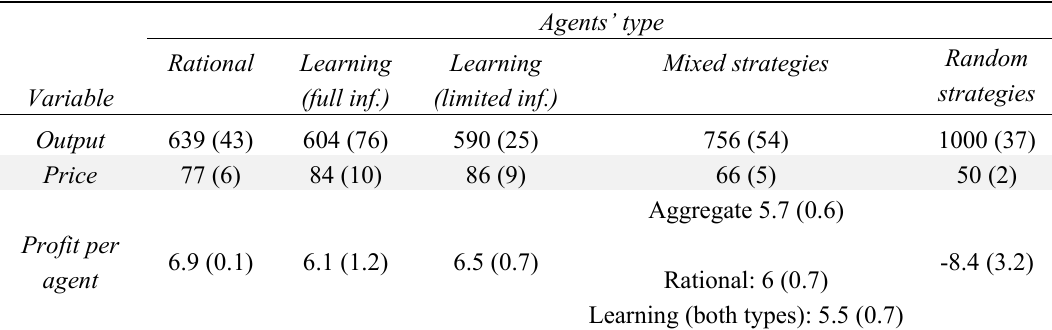
Table 1. Descriptive statistics of artificial datasets: mean (standard